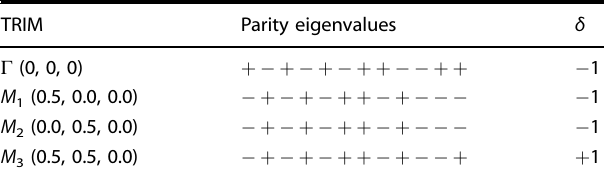
Table 1. Parity eigenvalues of all occupied bands and their products at four TRIM points. TRIM Parity eigenvalues δ Γ (0, 0, 0) + − + − + − + + − − + + −